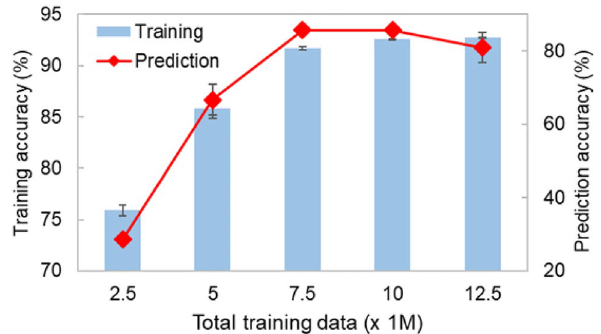
Figure 4. Optimization of training number. Analyzation accuracy for untrained films with type 4. Prediction accuracy was calculated through count of the true number divided by total interface (= 14 in Table S5). When prediction accuracy decreased at 12.5 million, over learning was observed.